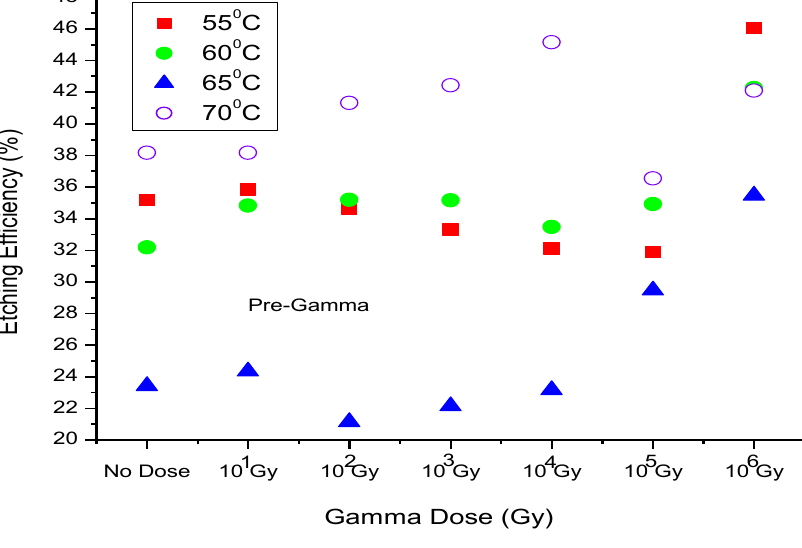
Figure 1. Plot of gamma dose vs. etching efficiency for pre -gamma radiation exposed PADC (American Acrylics) detectors at different etching